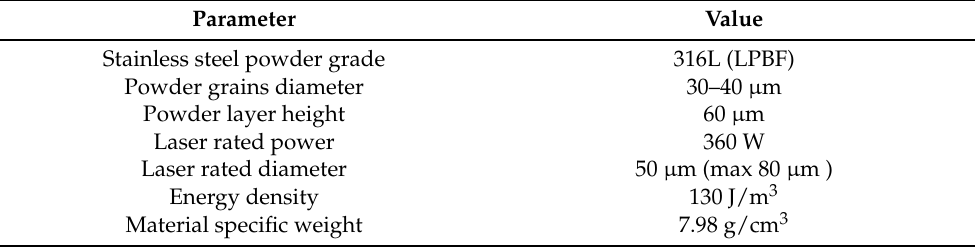
Table 1. 3D printing process parameters. LPBF, laser powder bed